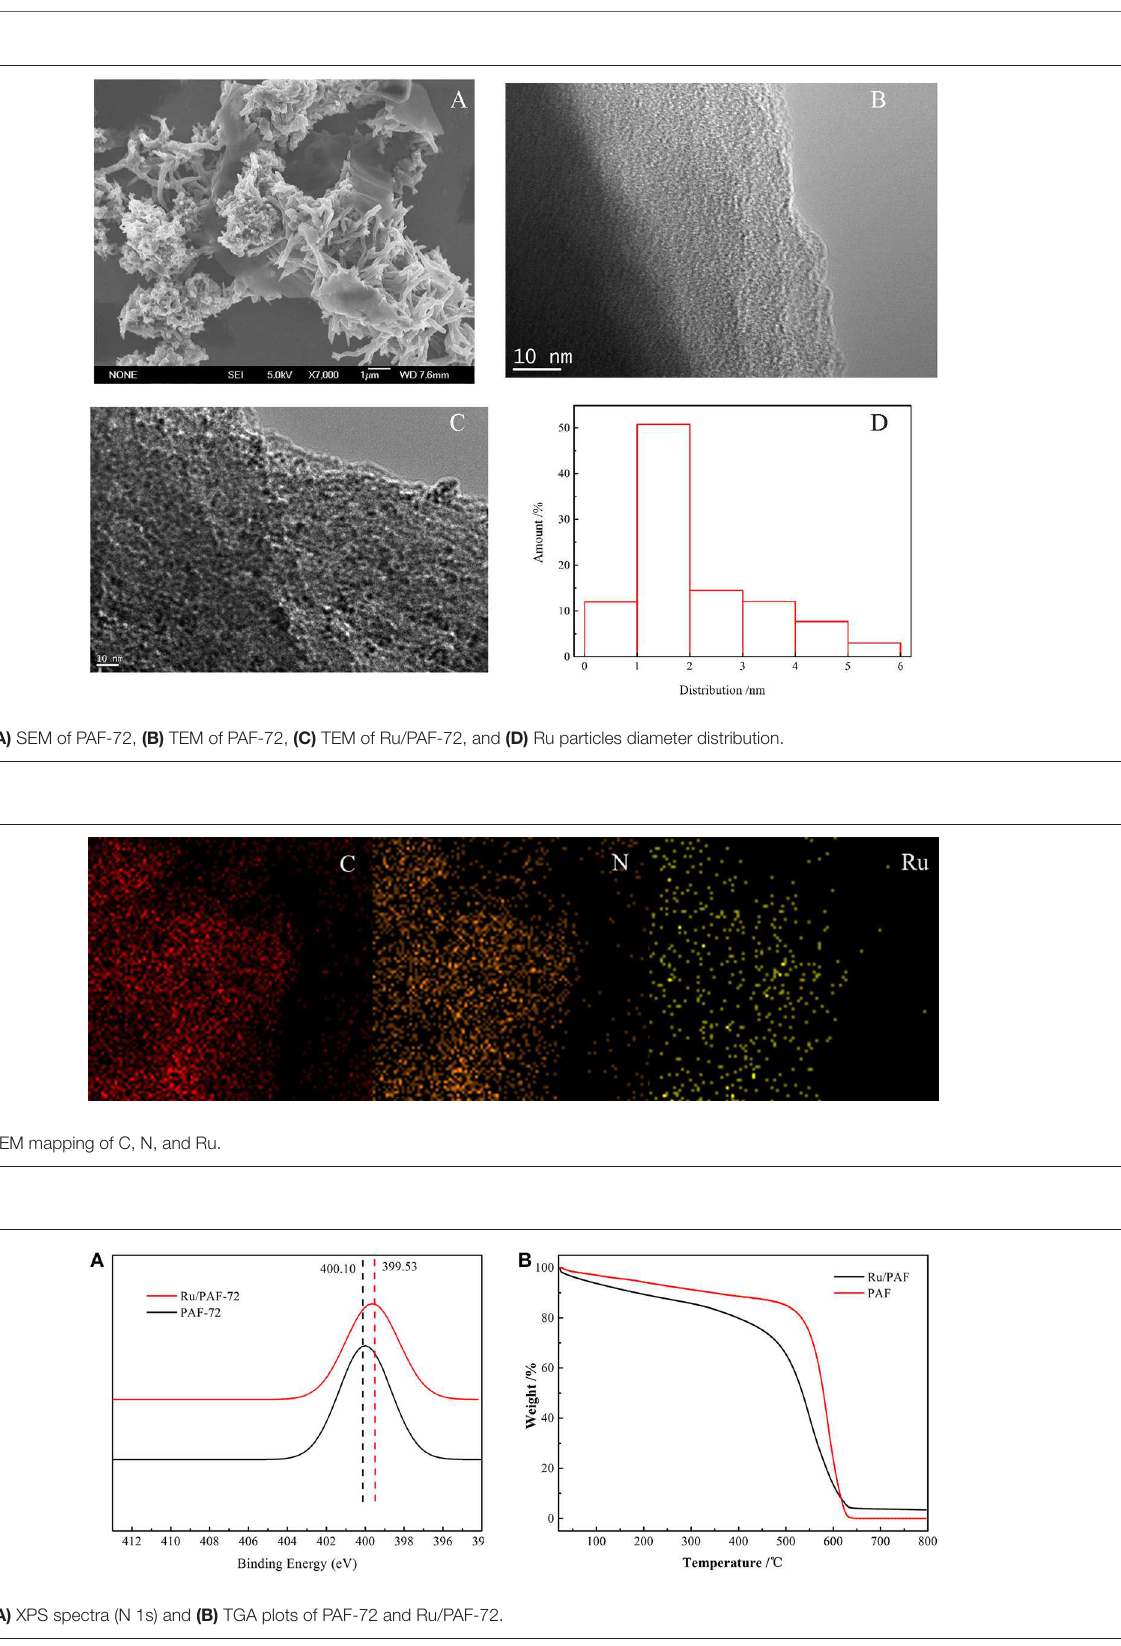
Frontiers in Materials |